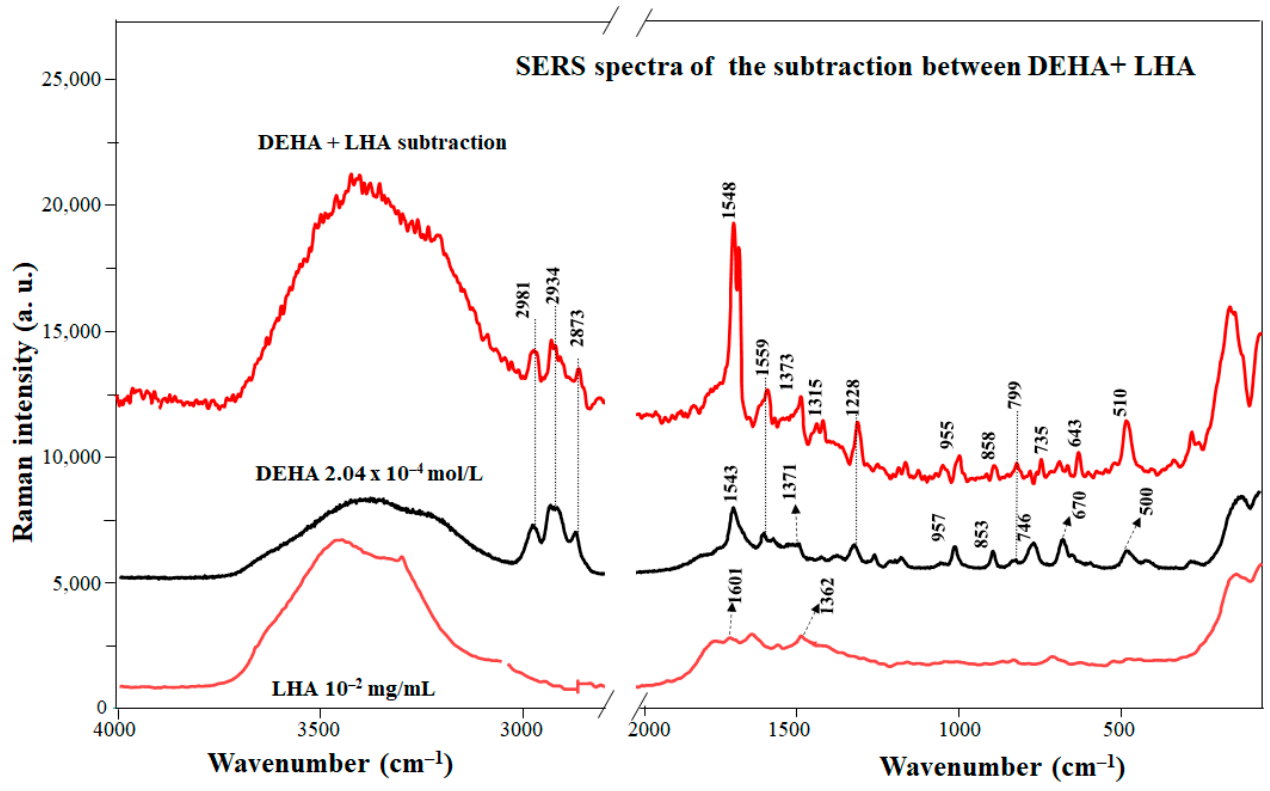
Figure 4. SERS spectrum of the DEHA/LHA complex and non-complexed